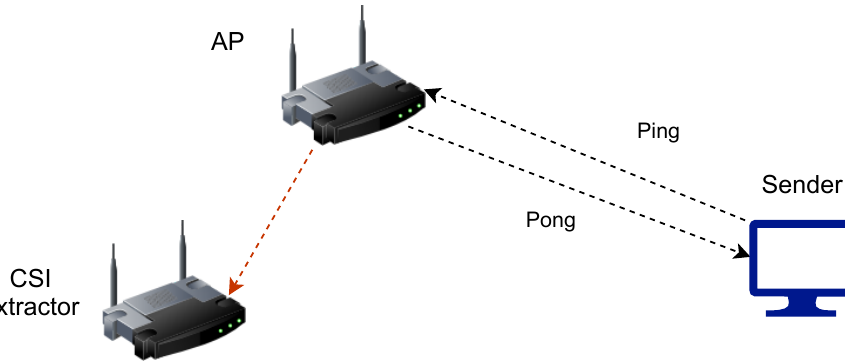
Figure 1. Wi-Fi frame captured at each